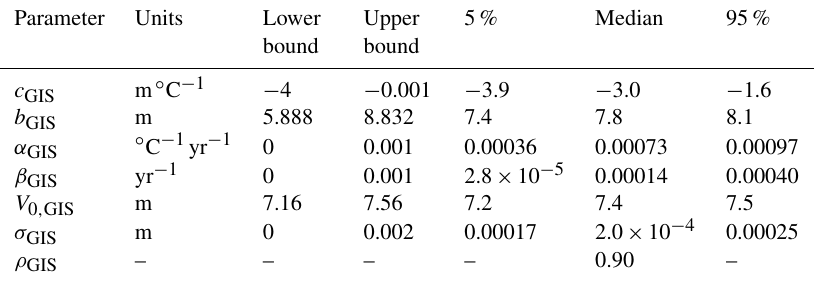
Table A3. Prior probability distribution ranges for the GIS-SIMPLE Greenland Ice Sheet model parameters, and median, 5th, and 95th quantiles of the calibrated posterior parameter distributions. The priors are all uniformly distributed. Due to convergence issues, ρ GIS is held fixed at a value calculated from a preliminary optimized model simulation (see main